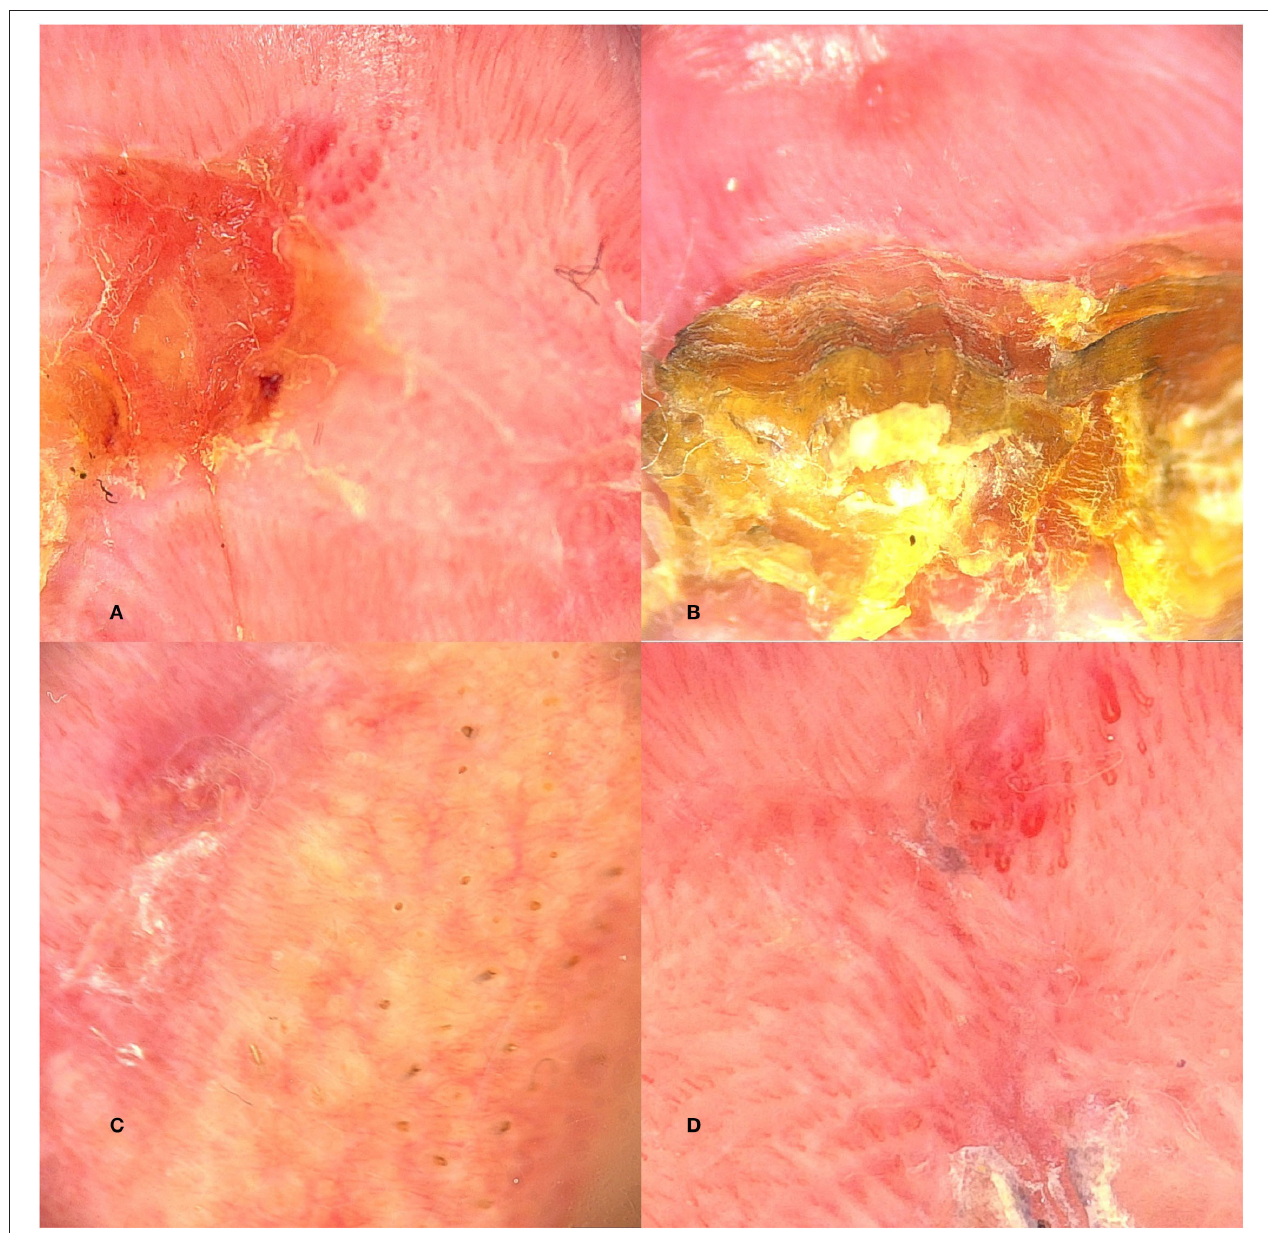
FIGURE 2 | Dermoscopic features of AC: (A) Structureless areas; (B) Scales; (C) White halo of the vermilion border; (D) Telangiectatic and torturous blood vessels.